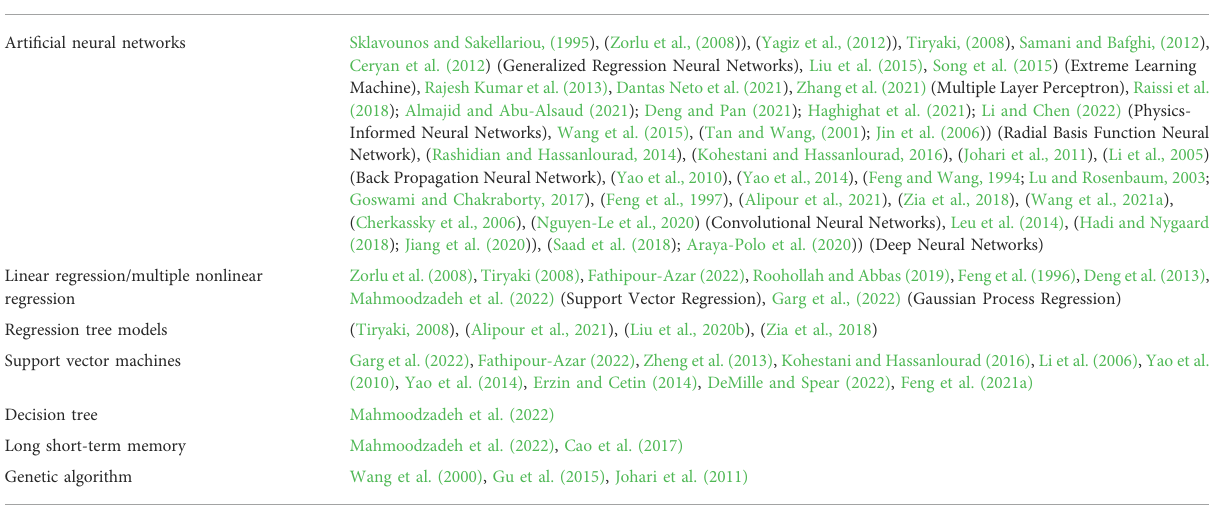
TABLE 1 List of references for common machine learning methods. Method